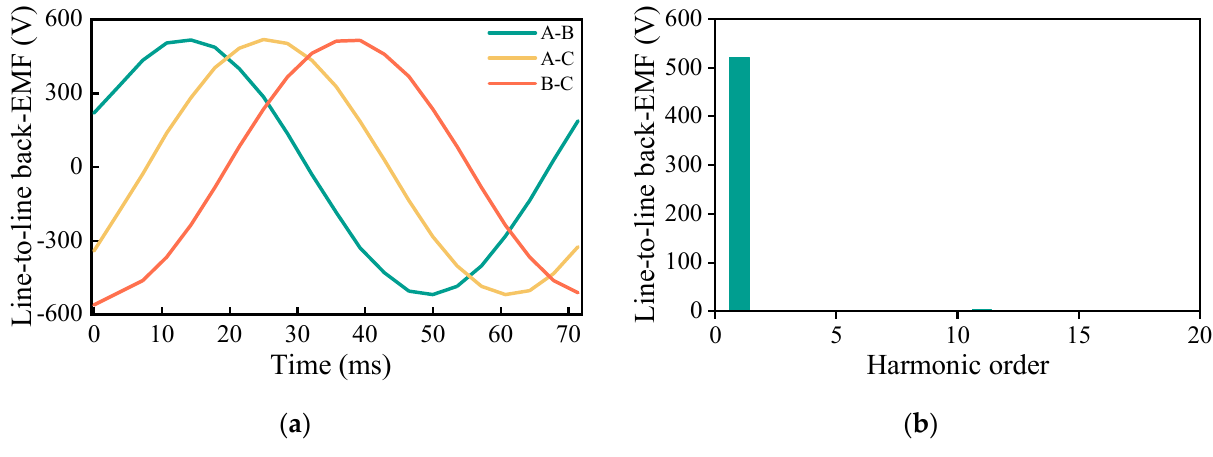
Figure 4. Line-to-line back-EMF and Fourier transform results: ( a ) line-to-line back-EMF waveform; ( b ) Fourier transform.